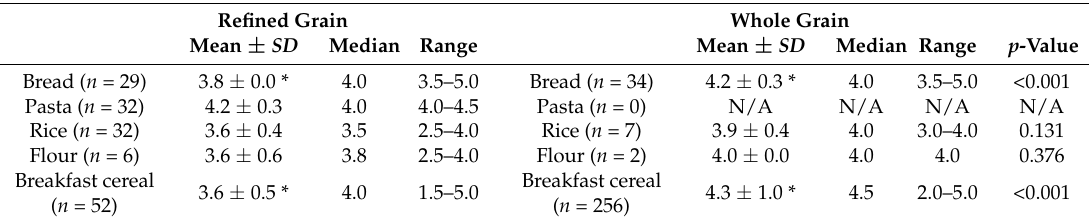
Table 2. Mean HSR for refined and whole grain food subcategories, including standard deviation, median and range.